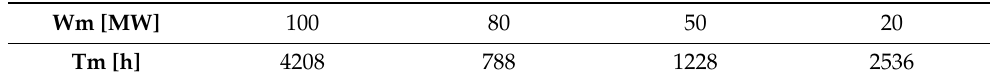
Table 2. Parameters of the cumulative load [26].